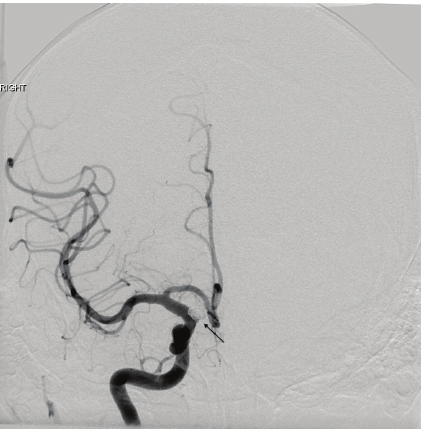
Figure 7: Postendovascular coiling of ICA aneurysm angiogram (arrow) demonstrating complete obliteration.